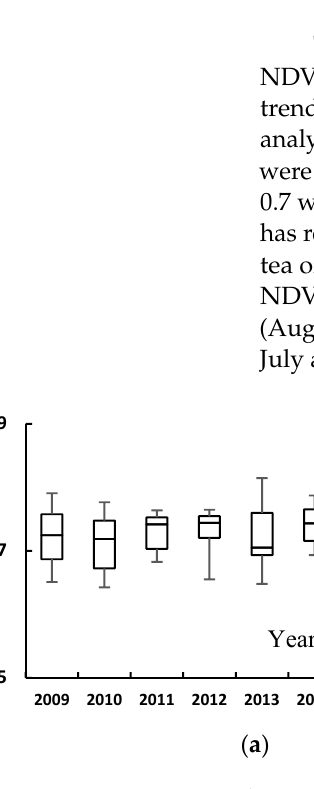
Figure 3. ( a ) Annual variations in growing-season NDVI (Normalized Difference Vegetation Index), ( b ) shows the Mann- Kendall results for trend analysis ( α = 0.05, Z1 = − 1.96, Z2 = 1.96).